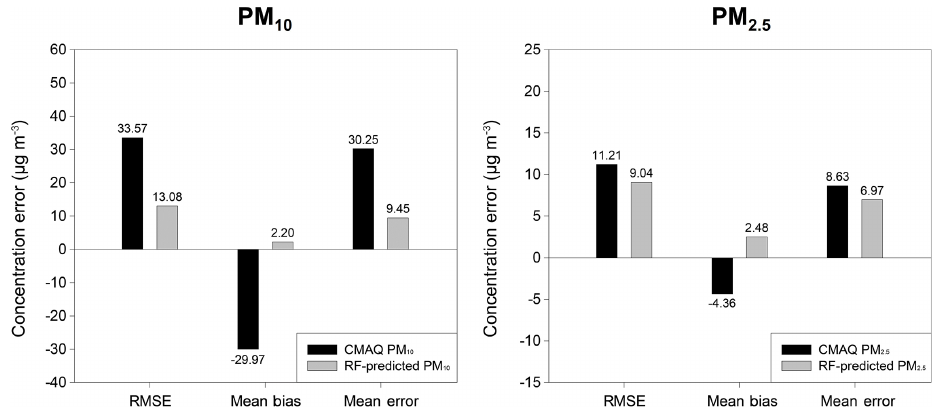
Figure 9. Comparison between the RF-based and CMAQ models using the hindcast validation data for estimating particulate matter concen- trations: PM 10 and PM 2 . 5 with root mean square error (RMSE), mean bias (MB), and mean error